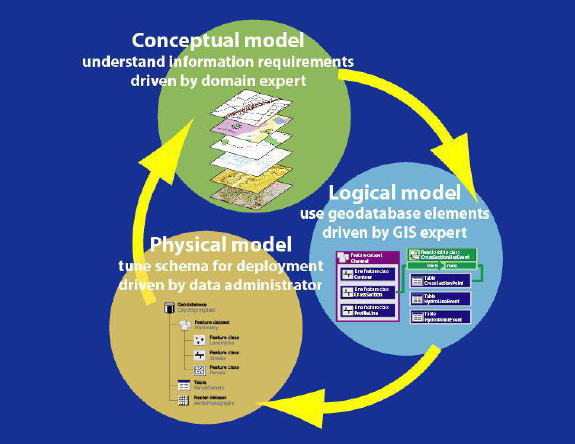
Fig. 3 - Conceptual modeling for the development of an ArcGIS geodatabase